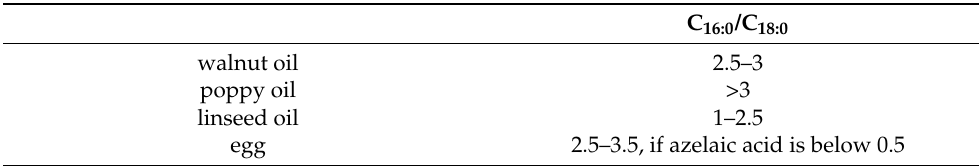
Table 3. C 16:0 /C 18:0 values for drying oils and egg. Data from